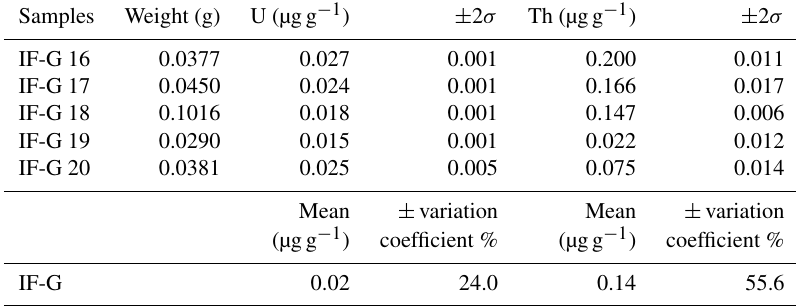
Table 3. U and Th concentration results obtained by